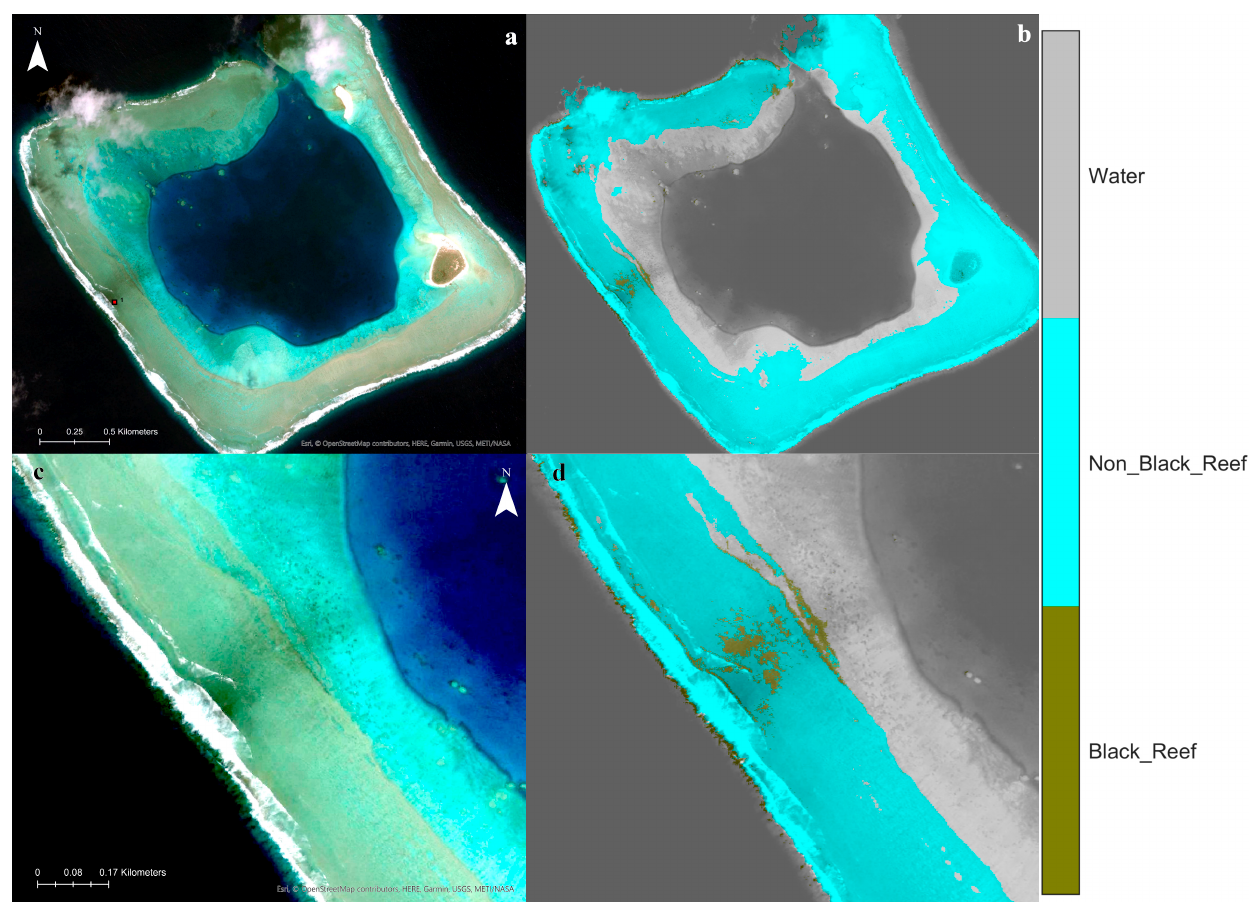
Figure 8. ( a ) Google Earth image (Google Earth Pro, 2011) from Rose reef with the location of the one known shipwreck (red dot), ( b ) the resulting segmented image after the application of the trained algorithm, ( c ) zoomed part of the location of the shipwreck showing the discoloration of the surrounding area, ( d ) the corresponding zoomed part of the segmented image.